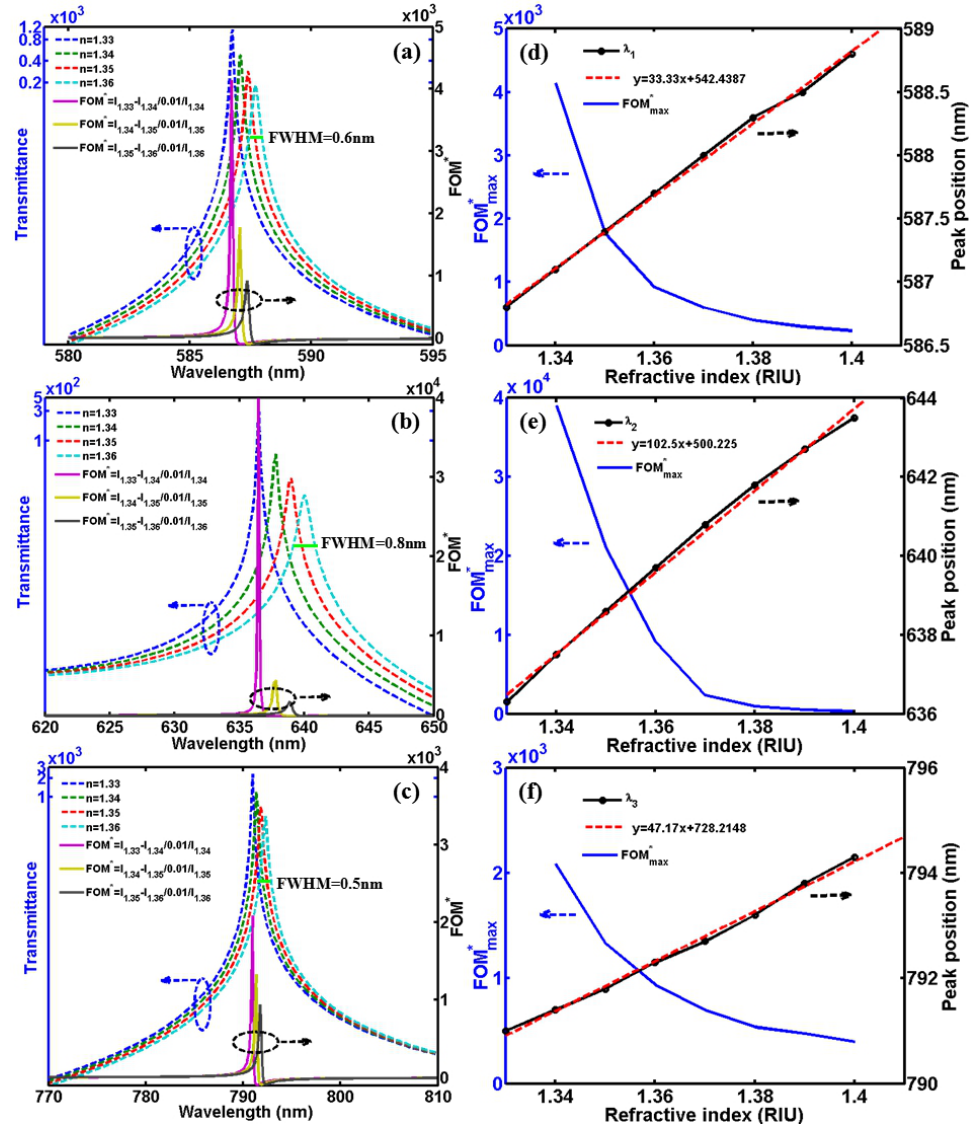
Fig. 7. (a)–(c) Transmission spectra and FOM* of the resonant peaks ( λ 1 − λ 3 ) when the structure is immersed in sodium chloride–water mixture solutions with varying concentrations. (d)–(f) The FOM*max and peak positions for the resonant peaks ( λ 1 − λ 3 ) as a function of the varying RI,